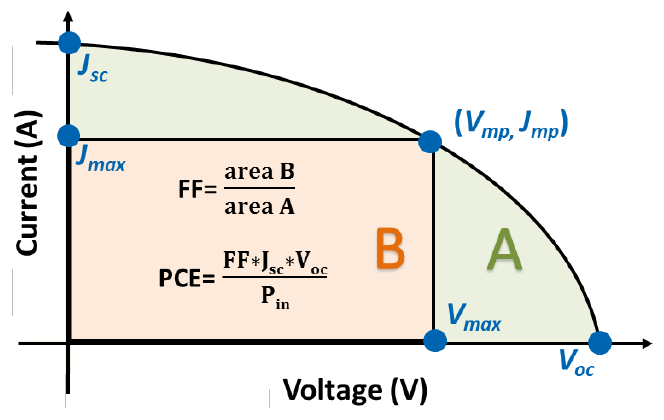
Figure 4. Typical current density ( J )-voltage ( V ) curve of